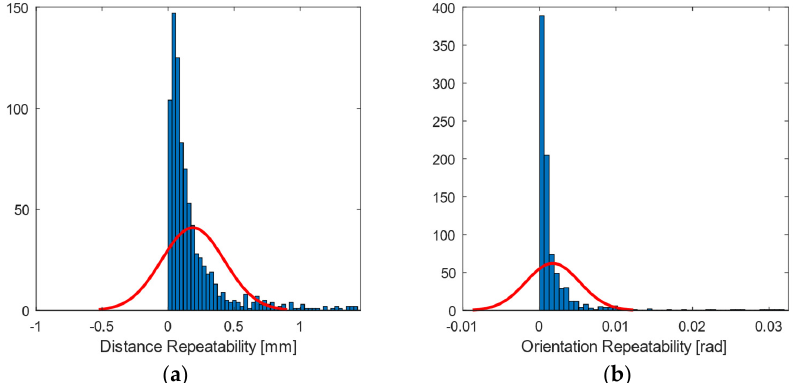
Figure 13. Histogram plot of the 97th percentile for spatial repeatability in ( a ) position (mm); and ( b ) orientation (rad). The red line represents a normal distribution as a comparison.